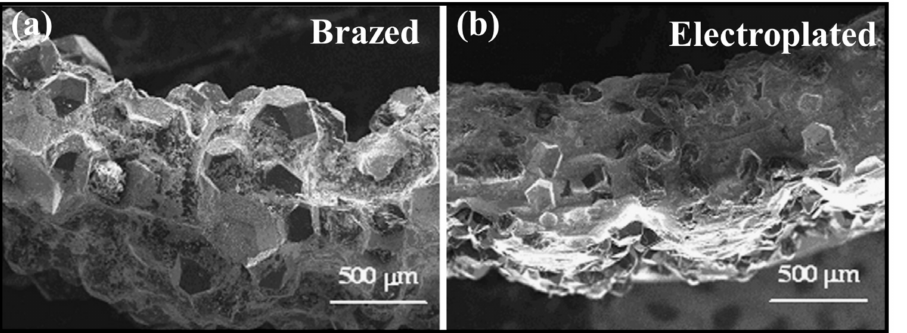
Figure 18. SEM images of local morphology of brazed ( a ) and electroplated ( b ) diamond boring drill bit. Reprinted with permission from Ref. [25]. Copyright 2009,